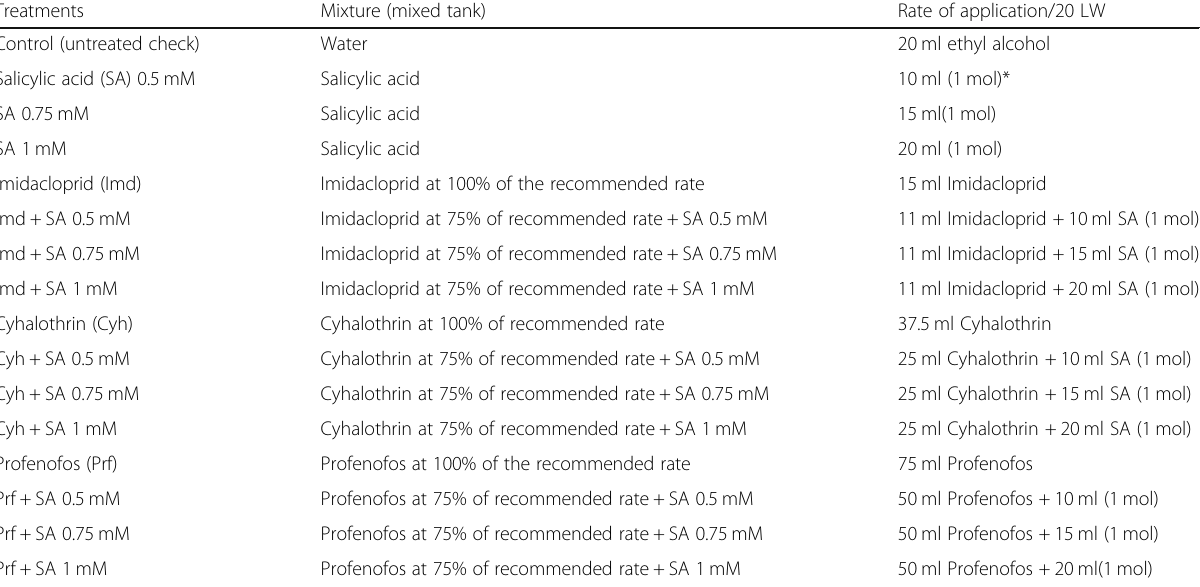
Table 1 Mixtures of insecticides/salicylic acid used in the field experiments and their application rates Treatments Mixture (mixed tank) Control (untreated